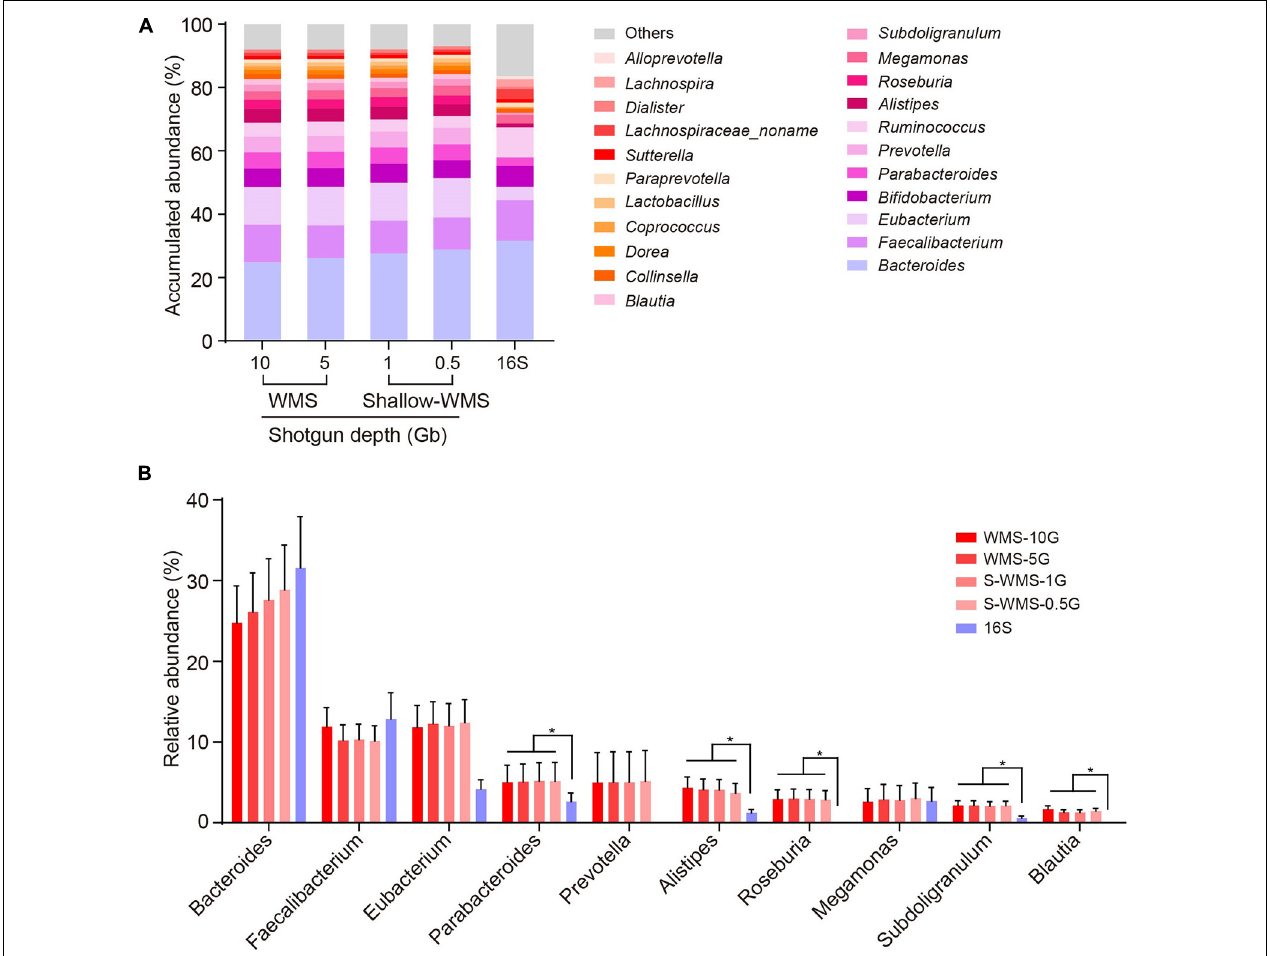
FIGURE 1 | Comparison of genus profiling of human fecal samples by 16S rRNA gene amplicon sequencing (16S) or WMS sequencing with different depths. (A) Stacked bar plot of genera abundances. (B) The relative abundance of each key genus. The metagenomes of 10 human stool samples were sequenced by both 16S amplicon and WMS sequencing at 0.5, 1, 5, and 10 Gb depths, with the deep (10 Gb) shotgun sequencing as reference. * p <